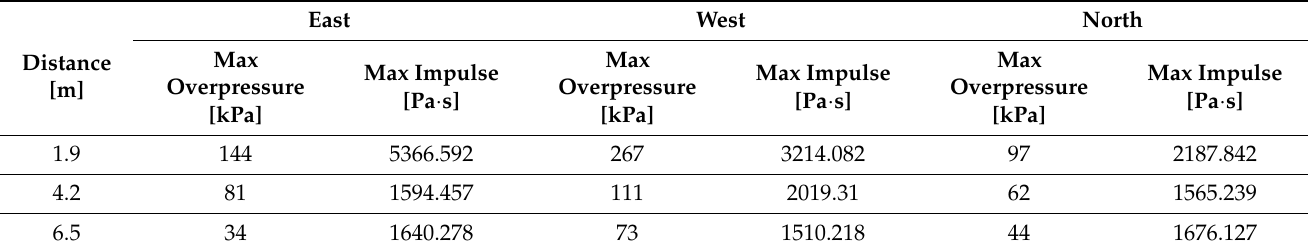
Figure 7. Incident pressures induced by the hydrogen tank explosion: ( a ) east direction; ( b ) north direction; ( c ) west direction.